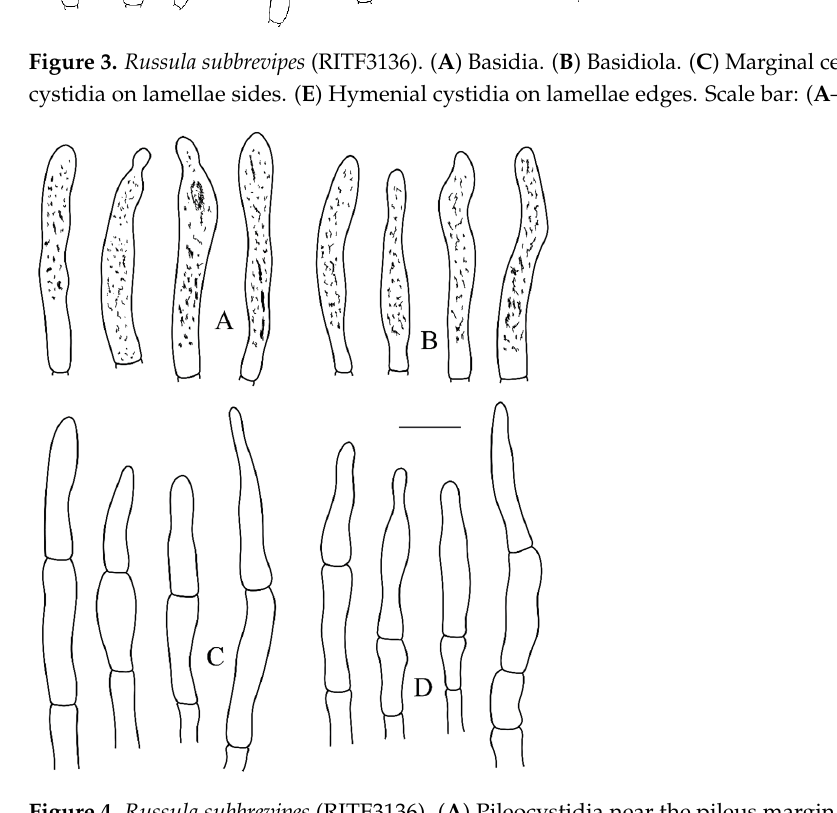
Figure 4. Russula subbrevipes (RITF3136). ( A ) Pileocystidia near the pileus margin. ( B ) Pileocystidia near the pileus center. ( C ) Hyphal terminations near the pileus margin. ( D ) Hyphal terminations near the pileus center. Scale bar: ( A – D ) = 10 μ m.